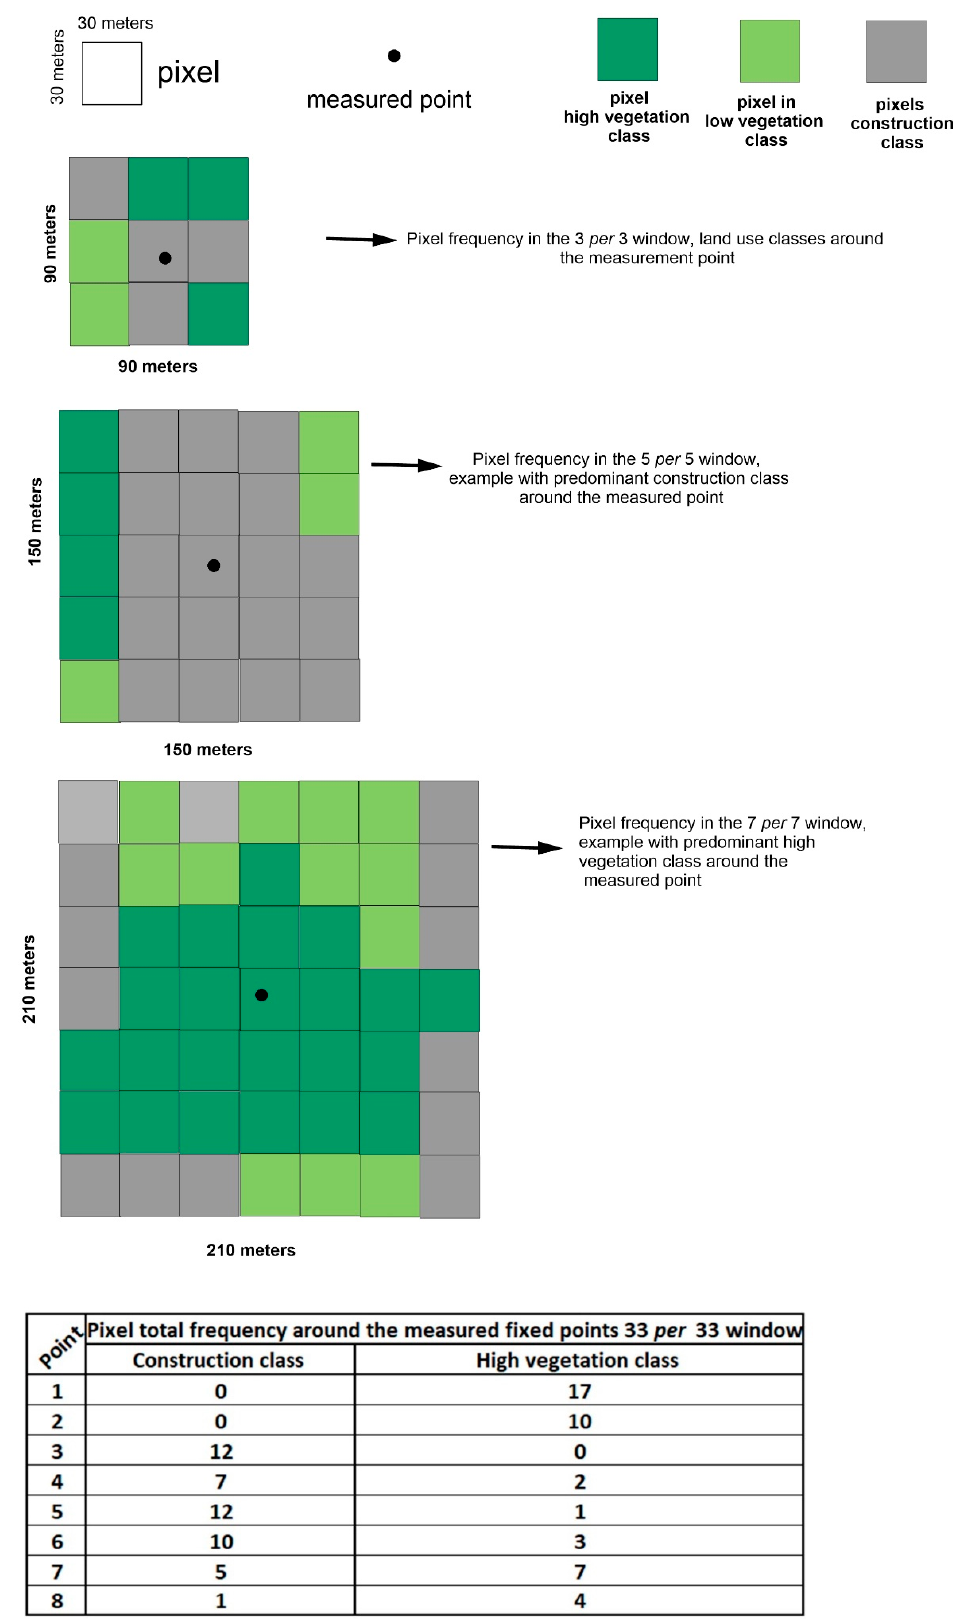
Figure 3. Calculation of pixel total frequency around the measured fixed points and generalization of spatial information. Elaborated by the authors